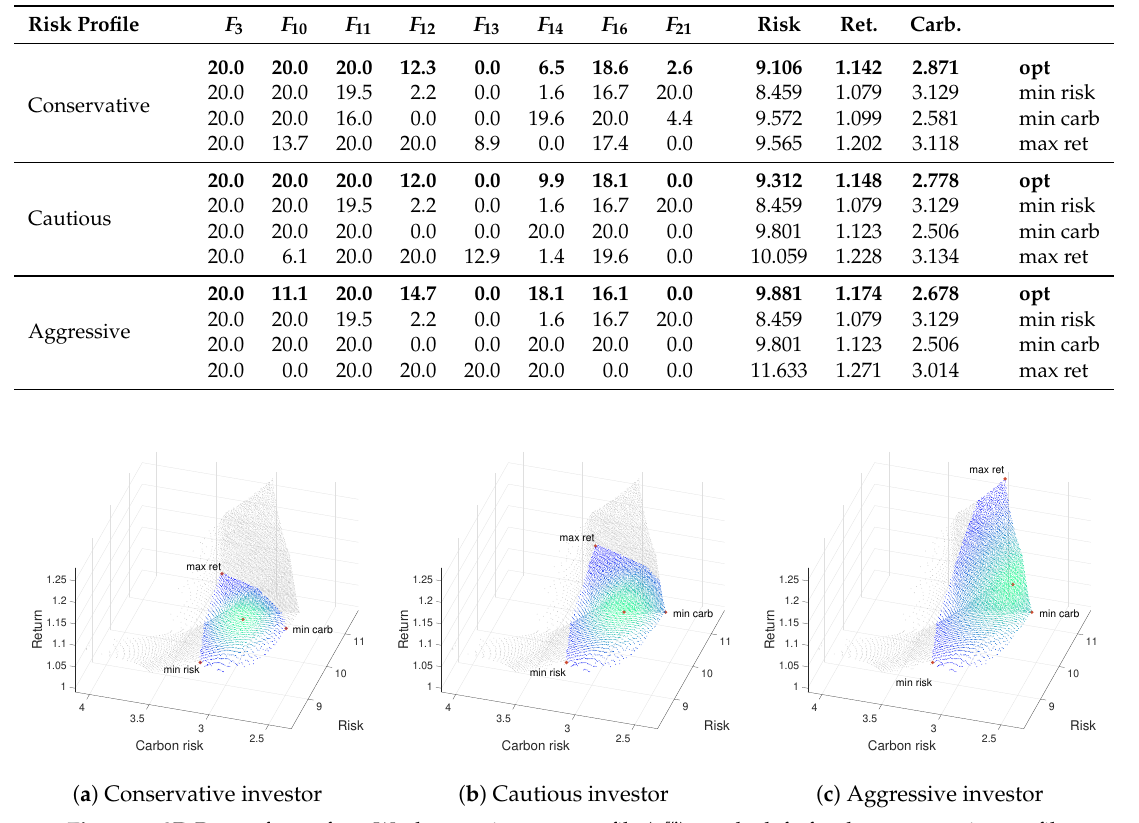
Figure 2. 3D Pareto fronts for a Weak green investor profile ( p w g ): on the left, for the conservative profile ( p c r ); on the center for the cautious investor ( p k r ); and on the right the aggressive profile ( p a r